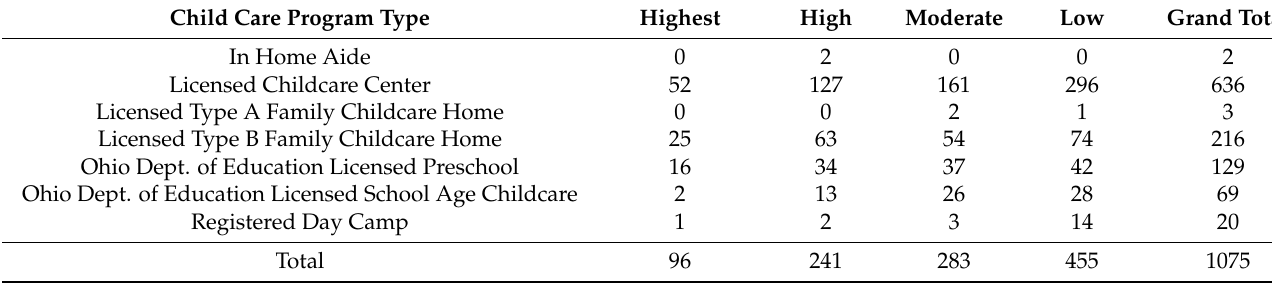
Table 5. Childcare centers by lead risk